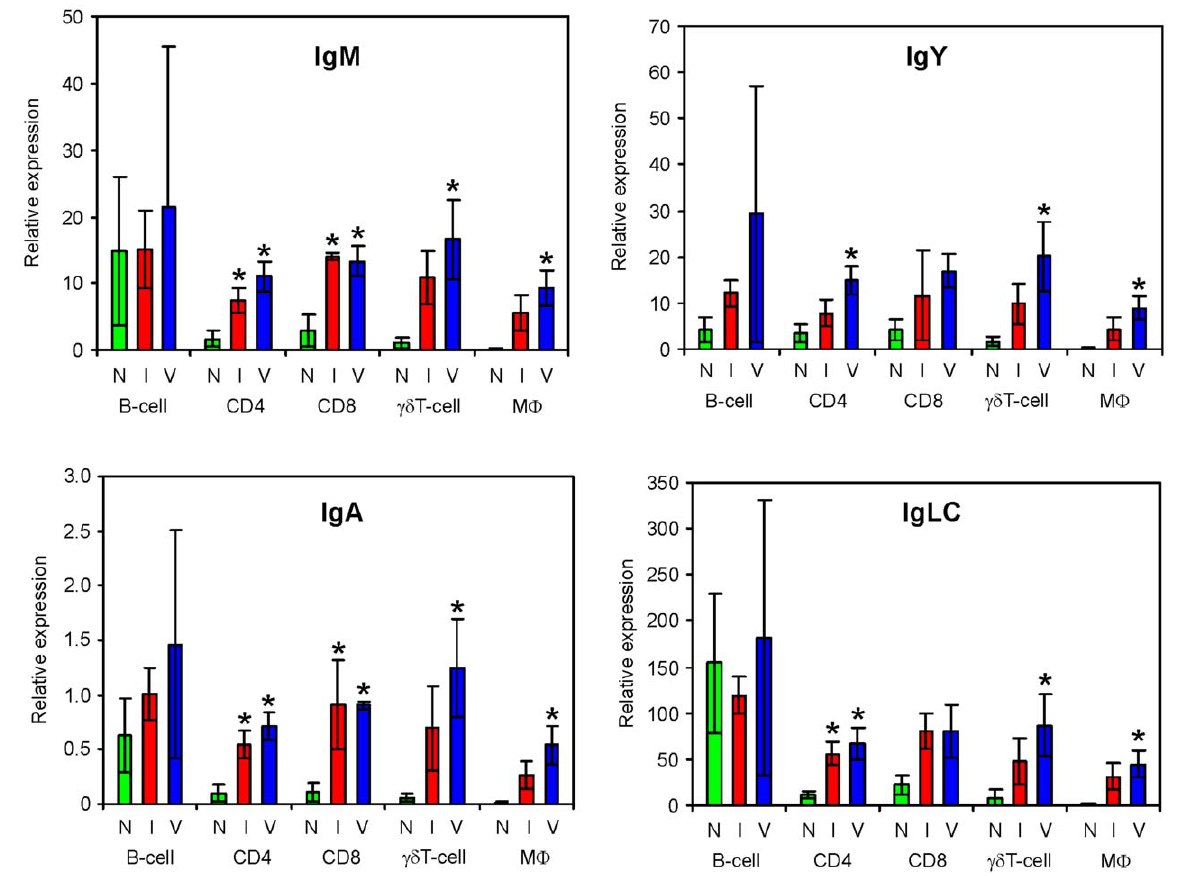
Figure 3. Real-time PCR quantification of transcripts coding for constant parts of immunoglobulins in leukocyte subpopulations. Leukocyte subpopulations were sorted from the spleen of non-infected (N), infected (I) and vaccinated and infected (V) chickens. The infected chickens were i.v. inoculated on day 42 of life and sacrificed 4 days later. IgLC – l light immunoglobulin chain. Asterisks indicate a significant difference between the expression in sorted leukocyte subpopulations of infected or vaccinated and infected chickens from the same subpopulation of the non-infected chickens (ANOVA, P , 0.05).